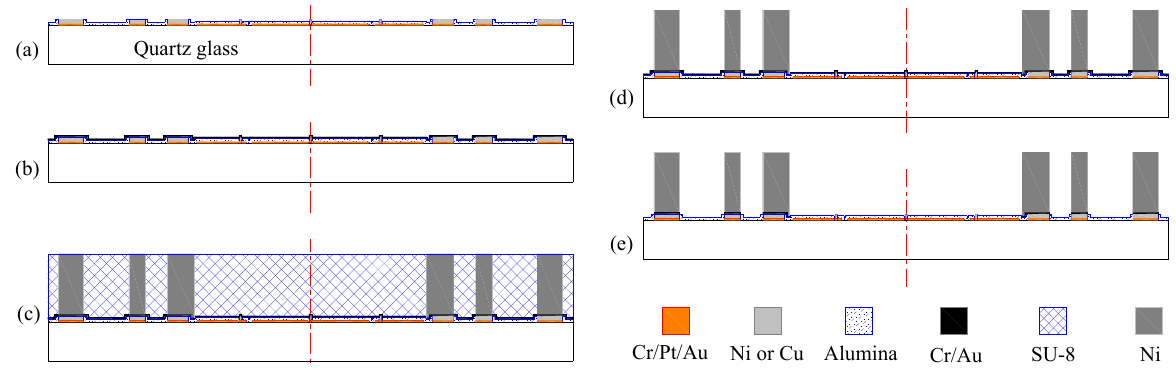
Figure 7. Schematic diagram of the fabrication process of the bottom